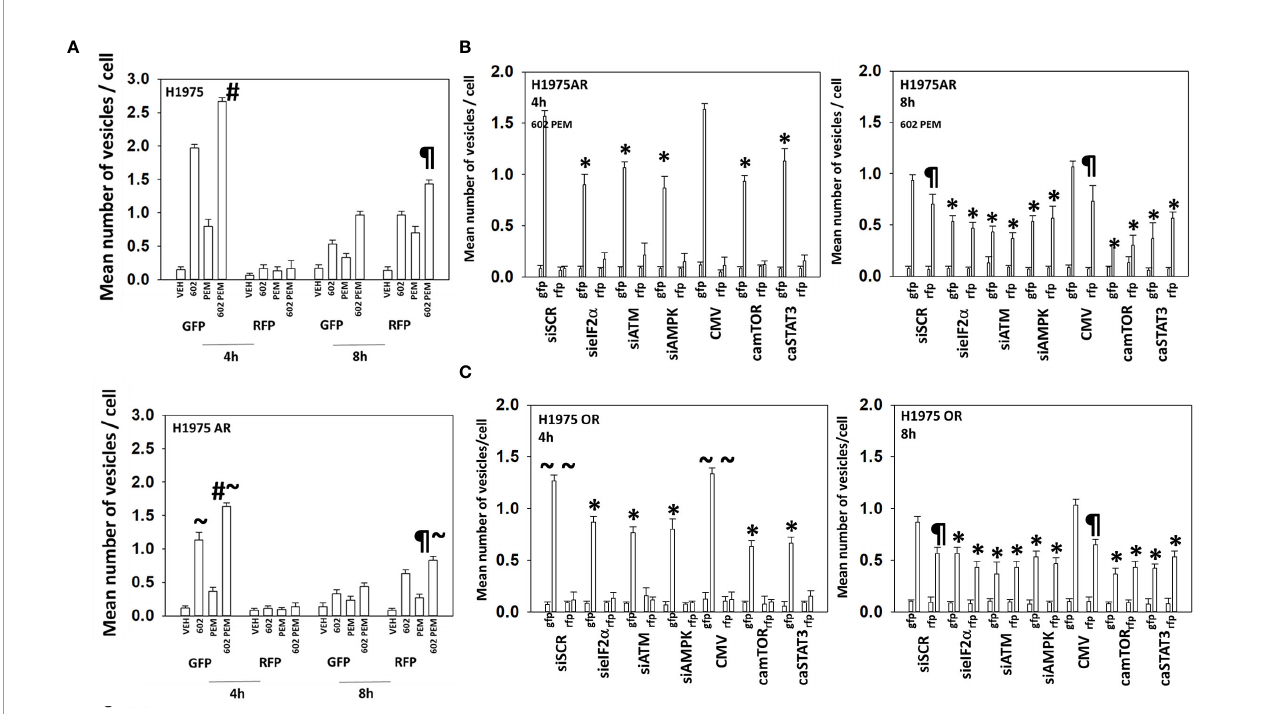
FIGURE 3 | Resistance to ERBB1 inhibitors is associated with a reduced ability to form autophagosomes. (A) H1975 [wild-type sensitive and afatinib-resistant (AR)] were transfected to express LC3-GFP-RFP and subsequently treated with vehicle, pemetrexed (500 nM), GZ17-6.02 (2 m M curcumin fi nal), or the drugs in combination for 4 h and 8 h. The number of intense staining GFP+ and RFP+ punctae was determined randomly in at least 50 cells, and the mean number of punctae per cell was determined ( n = 3 ± SD). # p < 0.05 greater than GZ17-6.02 value; ¶ p < 0.05 greater than the corresponding values after 4 h; ~ p < 0.05 less than the corresponding values in wild-type sensitive cells. (B) Afatinib-resistant H1975 cells were transfected with siRNA molecules to knock down protein levels or with plasmids to express activated forms of mTOR or STAT3 and then subsequently treated with vehicle or [pemetrexed (500 nM) + GZ17-6.02 (2 m M curcumin fi nal)] in combination for 4 h and 8 h. The number of intense staining GFP+ and RFP+ punctae were determined randomly in at least 50 cells, and the mean number of punctae per cell was determined ( n = 3 ± SD). ¶ p < 0.05 greater than the corresponding values after 4 h; * p < 0.05 less than the corresponding values in siSCR/ CMV-transfected cells. (C) Osimertinib-resistant H1975 cells were transfected with siRNA molecules to knock down protein levels or with plasmids to express activated forms of mTOR or STAT3 and then subsequently treated with vehicle or [pemetrexed (500 nM) + GZ17-6.02 (2 m M curcumin fi nal)] in combination for 4 h and 8 h. The number of intense staining GFP+ and RFP+ punctae was determined randomly in at least 50 cells and the mean number of punctae per cell determined ( n = 3 ± SD). ¶ p < 0.05 greater than the corresponding values after 4 h; ~~ p < 0.05 less than the corresponding values in afatinib-resistant H1975 cells; * p < 0.05 less than the corresponding values in siSCR/CMV-transfected